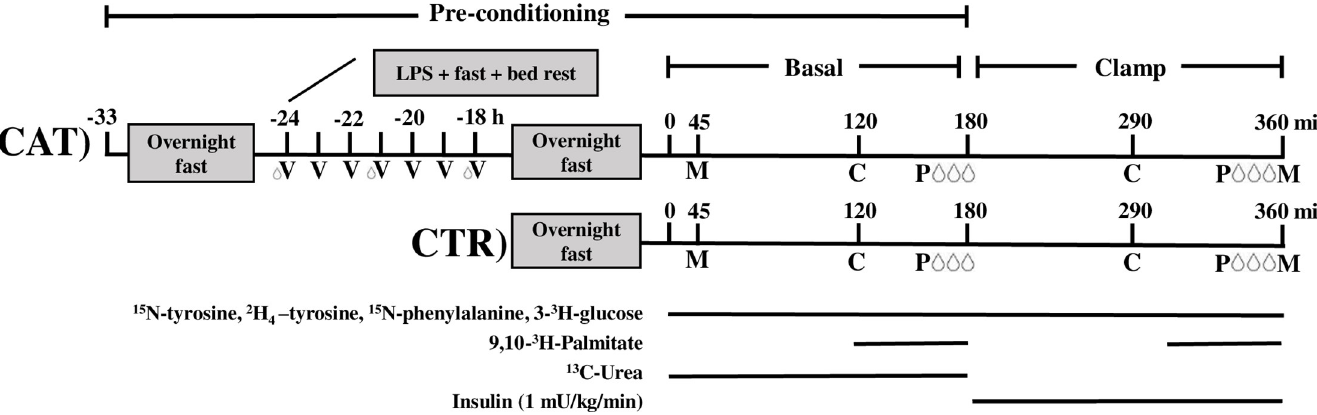
Fig 2. Design of the study. CAT (pre-conditioning with lipopolysaccharide) (LPS, 1 ng/kg) exposure (inflammation) + 36 hour bed rest and fast, CTR (pre- conditioning with an overnight fast), vital parameters (V), calorimetry (C), plethysmography (P), blood sample (droplet) and muscle biopsy (M).